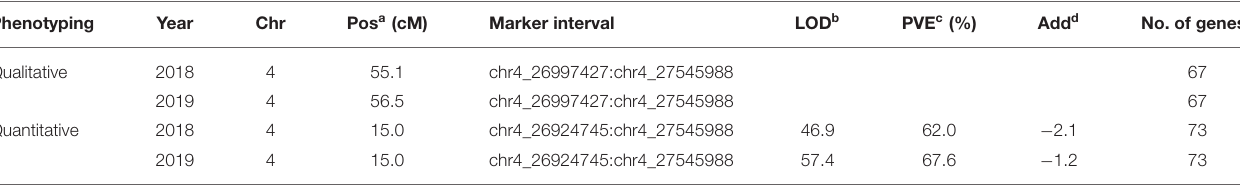
TABLE 2 | Genetic mapping for the compound raceme inflorescence in the RIL population derived from VC1973A × IT208075. Phenotyping